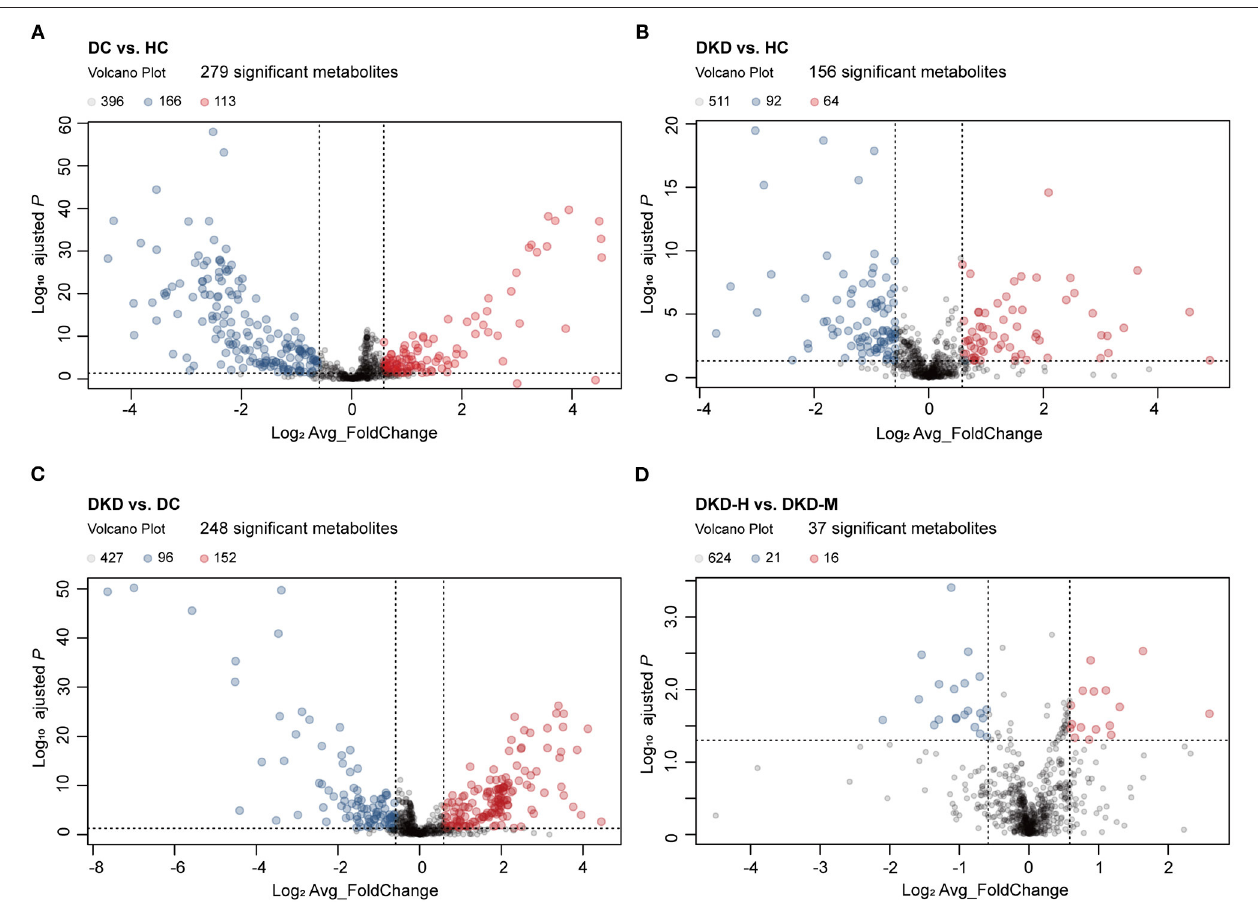
FIGURE 3 | Visualization of serum metabolites difference between healthy controls and diabetic patients. (A) Volcano plot comparing serum metabolites in diabetic controls (DC) ( n = 30) and healthy controls (HC) ( n = 30). The vertical dashed lines indicate the threshold for the 1.5-fold abundance difference. The horizontal dashed line indicates the P = 0.05 threshold. X-axis, log2[average_FoldChange]. Y-axis, –log10[adjusted- P value]. P -value computed using a two-sided unpaired t-test without adjustment for multiple comparisons. (B) Volcano plot comparing serum metabolites in diabetic kidney disease patients (DKD) ( n = 29) and healthy controls (HC) ( n = 30). Refer to (A) for the description of the figure. (C) Volcano plot comparing serum metabolites in diabetic kidney disease patients (DKD) ( n = 29) and diabetic controls (DC) ( n = 30). Refer to (A) for the description of the figure. (D) Volcano plot comparing serum metabolites in diabetic kidney disease with heavy proteinuria (DKD-heavy) ( n = 17) and diabetic kidney disease with moderate proteinuria (DKD-moderate) ( n = 12). Refer to (A) for the description of the figure.